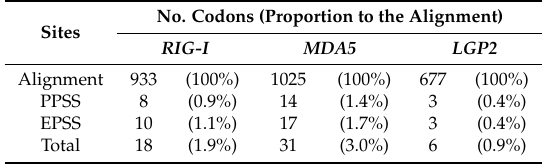
Table 3. Number of positively selected sites identified in the three avian RLR